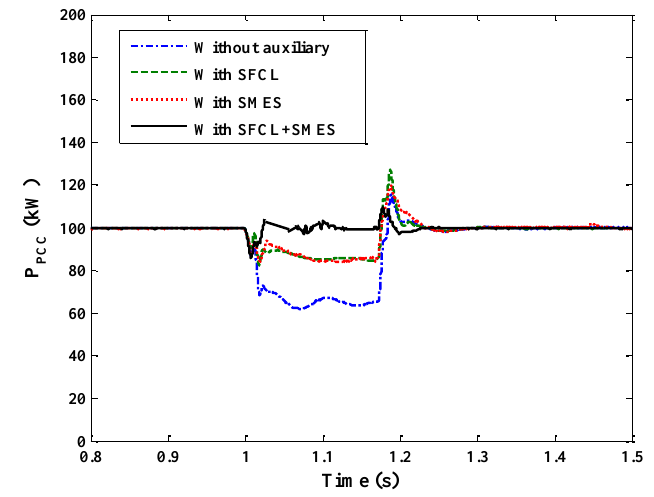
Figure 17. Simulation results of the PCC power under the asymmetrical fault.